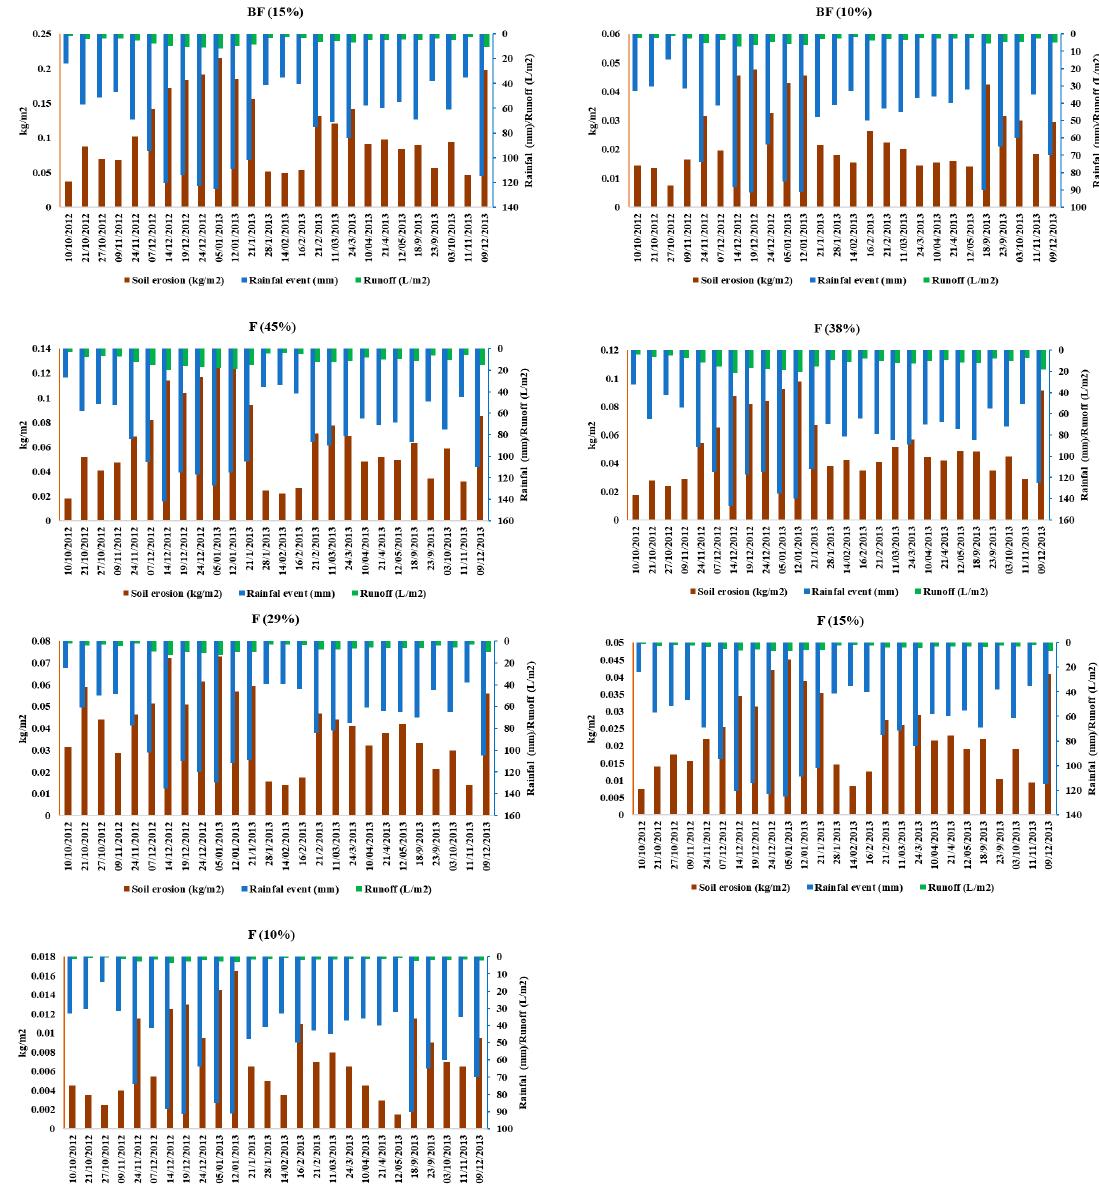
Figure A1. Dynamic interaction between erosion, runoff, and rainfall in each land use.